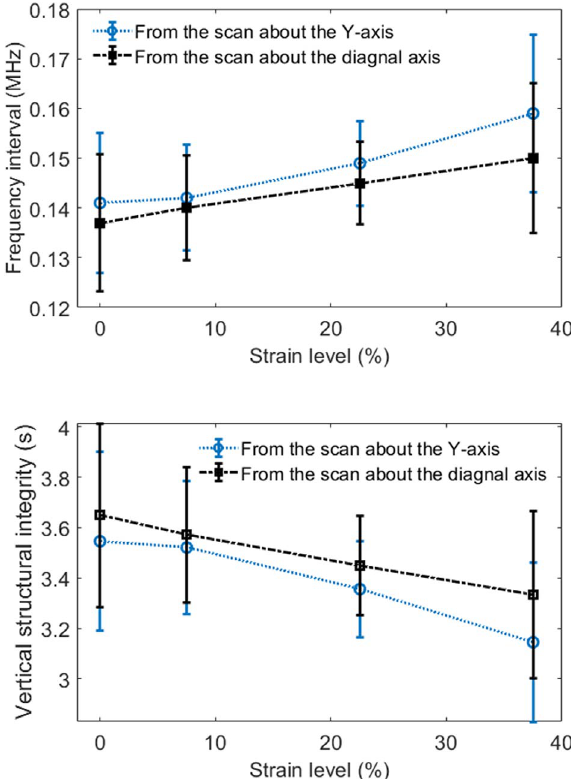
Figure 9. (Top) The frequency intervals were obtained from the comb fi ltering effect of the normal re fl ections during polar scans about the Y -axis and diagonal axis at four different strain levels. (Bottom) The vertical structural integrity indicator ( d/c ) is calculated from the top sub fi gure frequency